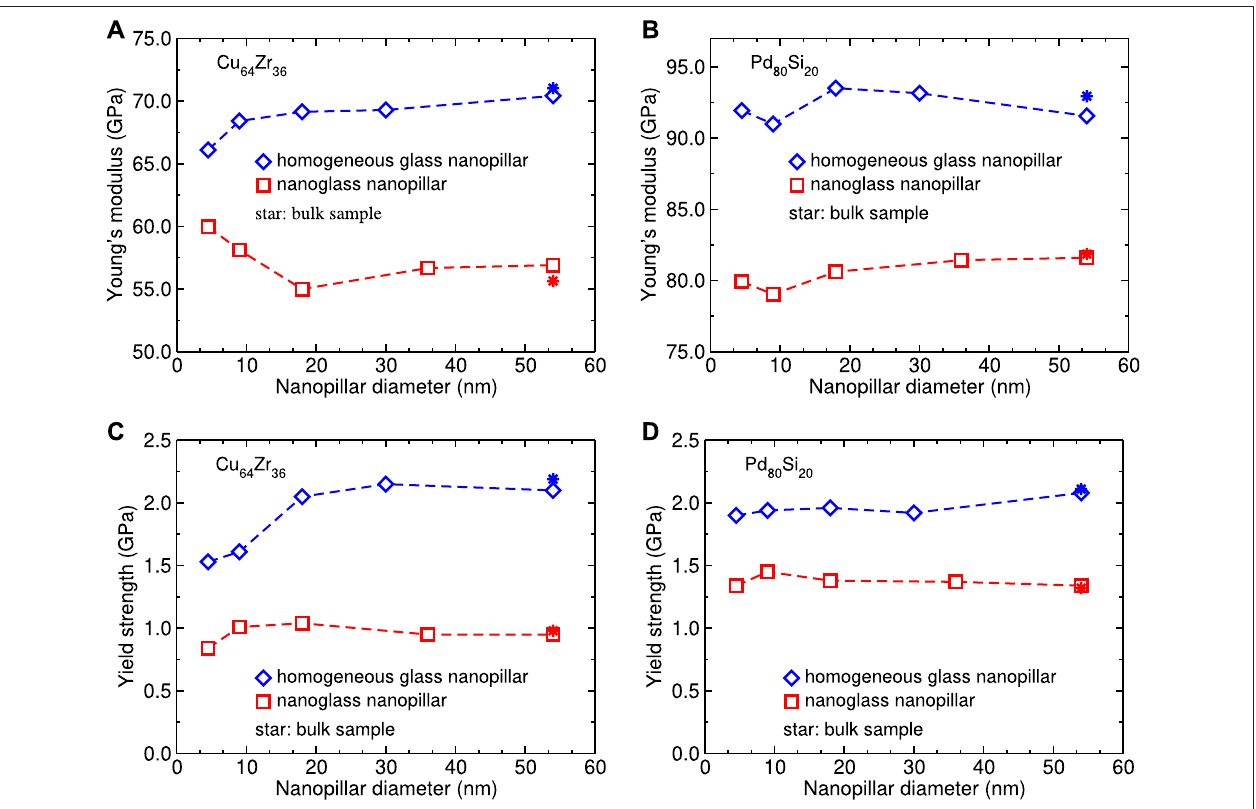
FIGURE3| EffectofsizeonYoung ’ smodulusandyieldstrengthofhomogeneousglass(HG)andnanoglass(NG)nanopillars. (A,B) Young ’ smodulusasafunction of the nanopillar diameter for Cu 64 Zr 36 and Pd 80 Si 20 NG and HG nanopillars. (C,D) Yield strength as a function of the nanopillar diameter for Cu 64 Zr 36 and Pd 80 Si 20 NG and HG nanopillars. The HG and NG bulk samples are added for